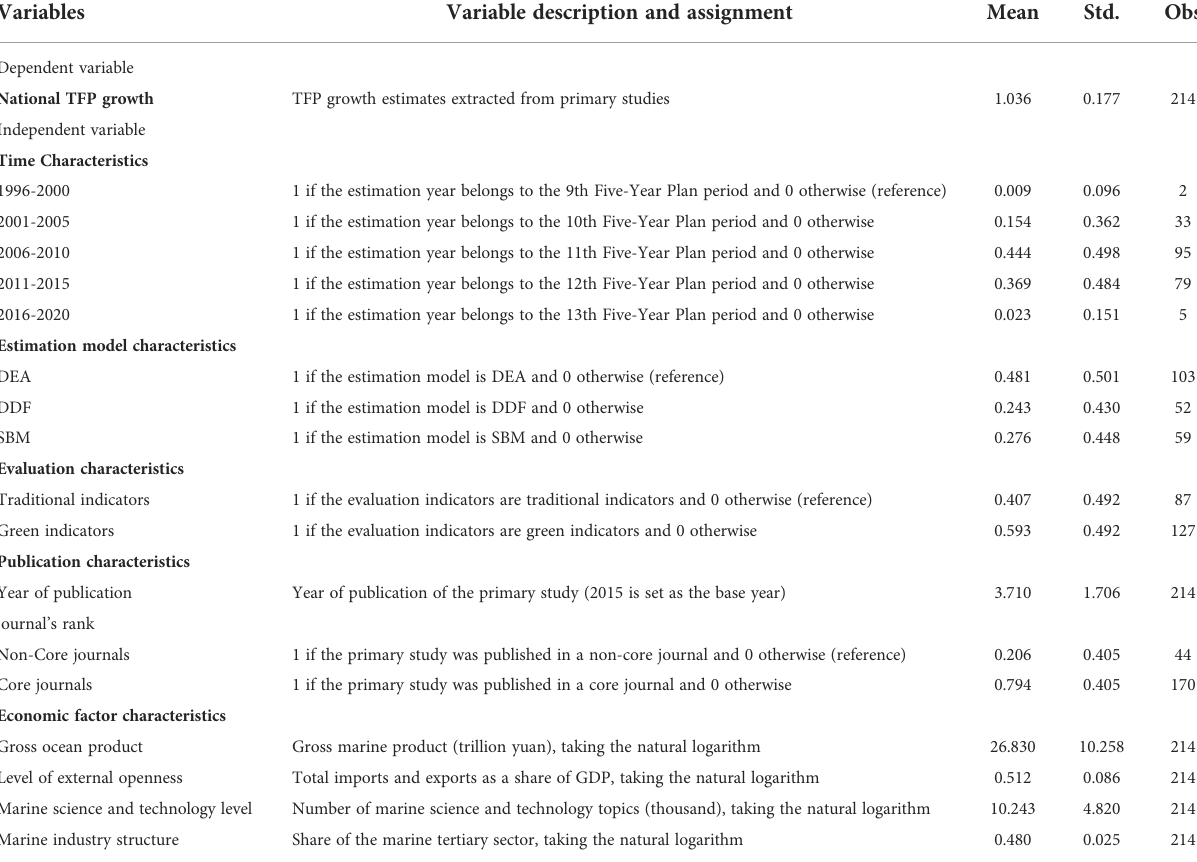
TABLE 3 Results of descriptive statistics of characteristic variables that incorporate with subsequent meta-regression analysis at the national level.